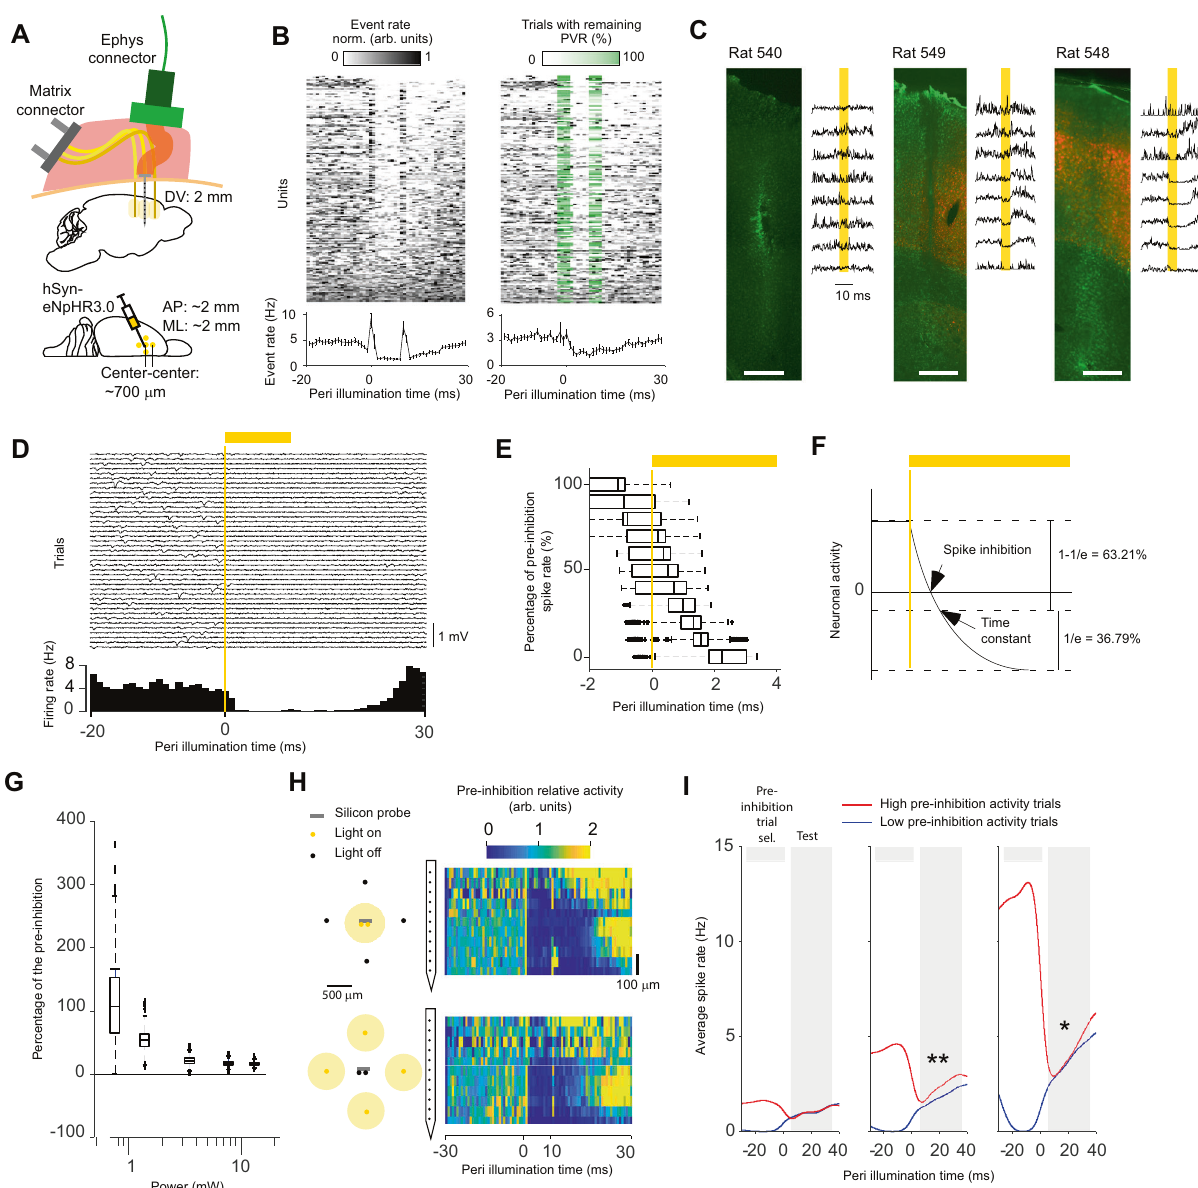
Fig. 2 Ultrafast optogenetic inhibition in freely moving animals. A Injection, stimulation, and recordings in M1. B Activity of sorted units without (left) and with (middle) PVR management. The PVR management algorithm fi rst subtracts an estimate of the PVR and then estimates in which trials the subtraction was incomplete. This remaining PVR trial percentage (green) is then used to weight the average across trials for each time point (lower left and right panel). The data shown are from animals 540, 548, and 549. C Relationship between opsin expression (red) and inhibition strength. To quantify the overall extracellular response, spikes were detected at a threshold of − 30 µ V on a per-channel basis without PVR management (PVR removed for visibility). GFAP immunostaining (green) was used to identify the BE probe location. Scale bar: 500 µ m. D Single-trial extracellular traces for 40 inhibitions from one electrode channel (upper panel). Histogram of spikes detected with a threshold of − 30 µ V (lower panel). E Latency at different percentages of the pre- inhibition spike rate bootstrapped across all sorted units. n = 212 sorted units over two animals. Boxplots: central mark indicates the median, bottom and top edges refer to the 25th and 75th percentiles of the bootstrapped data. F Illustration showing that the spike inhibition latency can be shorter than the time constant of the hyperpolarizing function. G Percentage of pre-inhibition spike rate as a function of the total light power that exits the side-emitting fi ber. n = 45, 45, 51, 63, and 63 sorted units with non-NaN-bins during stimulation for each light intensity, respectively. For a description of the Box-plot see panel E . H Comparison of inhibition in vivo for the BE probe (top) and the fi ber matrix (bottom). Spikes were detected at a threshold of − 30 µ V on a per- channel basis without PVR management. I Inferring neuronal activity after inhibition onset from pre-inhibition activity. The units were divided into three groups corresponding to low (left, p = 0.98), moderate (middle, p = 0.0035), and high (right, p = 0.0249) average fi ring rates. * p < 0.05, ** p < 0.01. Two- sided t -test. No adjustments for multiple comparisons. Source data are provided as a Source Data fi